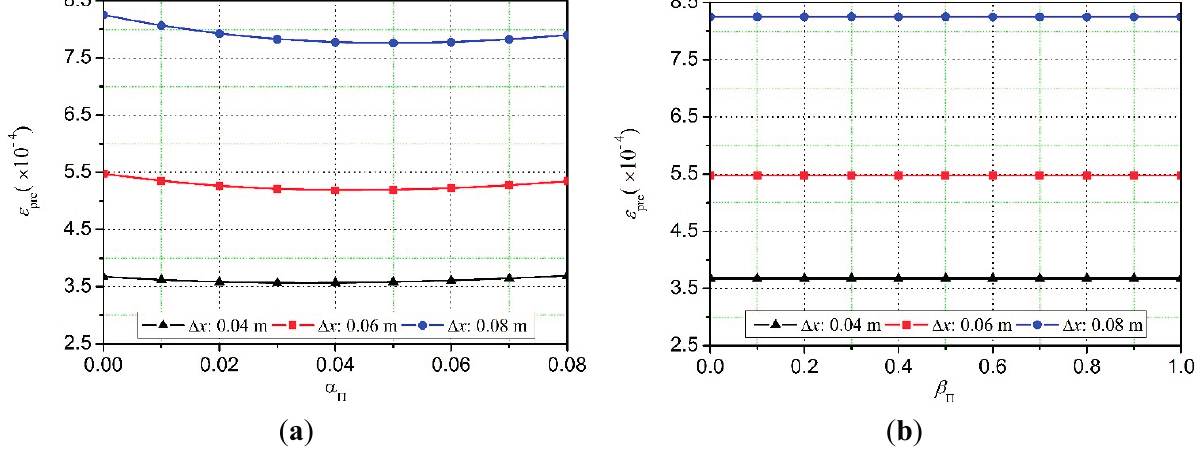
Figure 6. Numerical errors of sound pressure for sound interference models with different particle spacings. The smoothing kernel function is cubic spline, and the Courant number is 0.04. ( a ) Effects of α П on the simulation results at β П = 0.5; ( b ) effects of β П on the simulation results at α П =